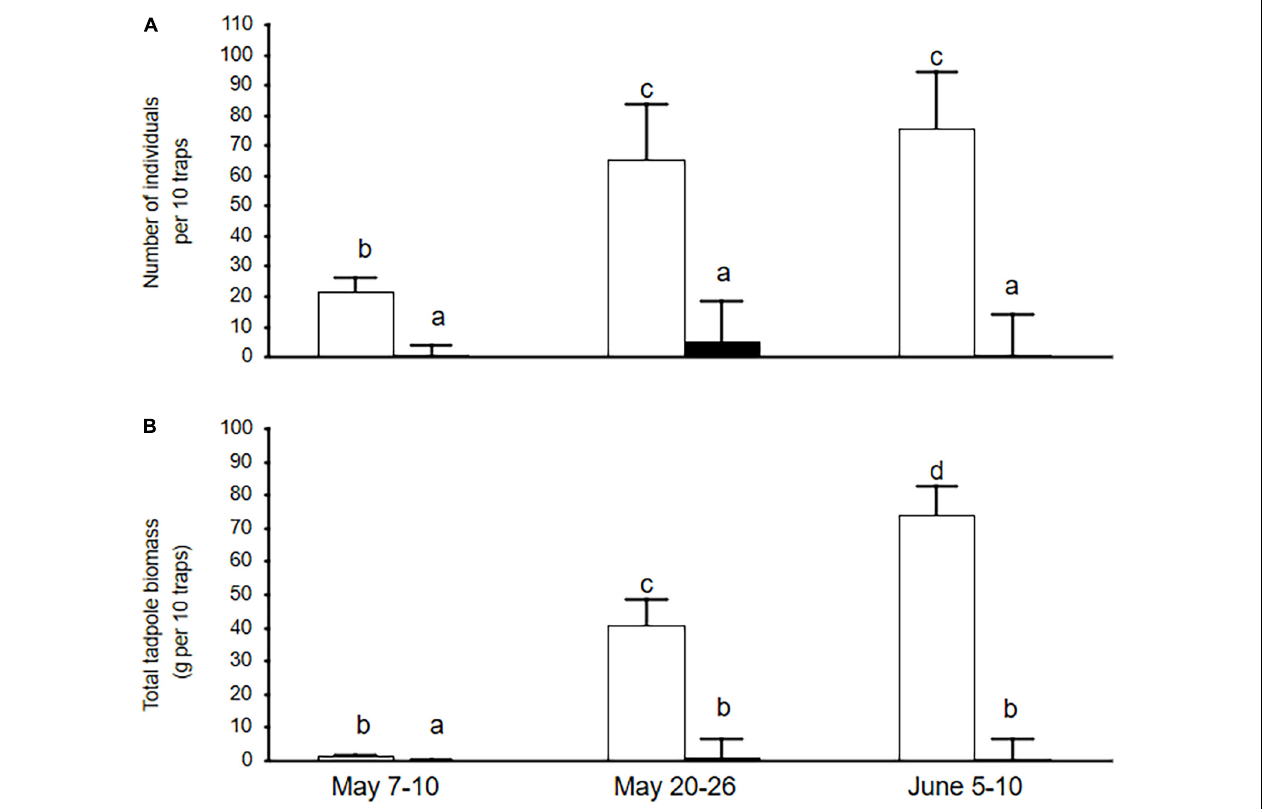
FIGURE 3 | Total numerical (A) and biomass (B) densities (means ± SE) of tadpoles in fish-poor (open bars) and fish-dominated (filled bars) ponds (REML repeated measures analysis). Data were based on three trapping sessions at approximately 2-week intervals. Different letters indicate significant differences between means according to the LSD